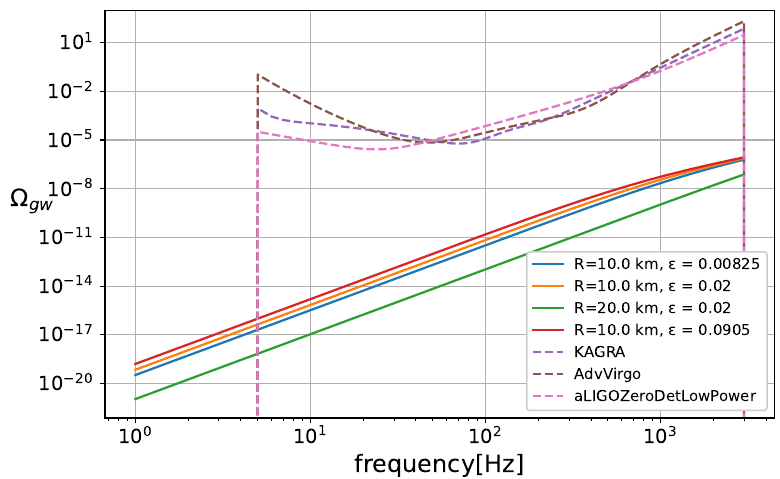
Figure 4. Variation of Ω gw ( f ) for different parametric preferences for the magnetar producing SGWB from the high-frequency model of the twisted-torus magnetic field configuration. Here, (cid:101) and R are the free parameters, respectively, and R are measured in km . Values of (cid:101) are chosen within the realist stellar range referred in Figure